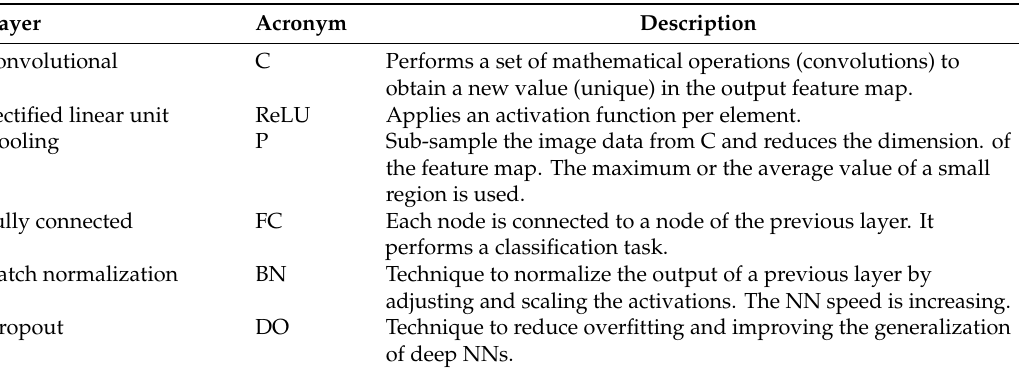
Table 2. CNN layers